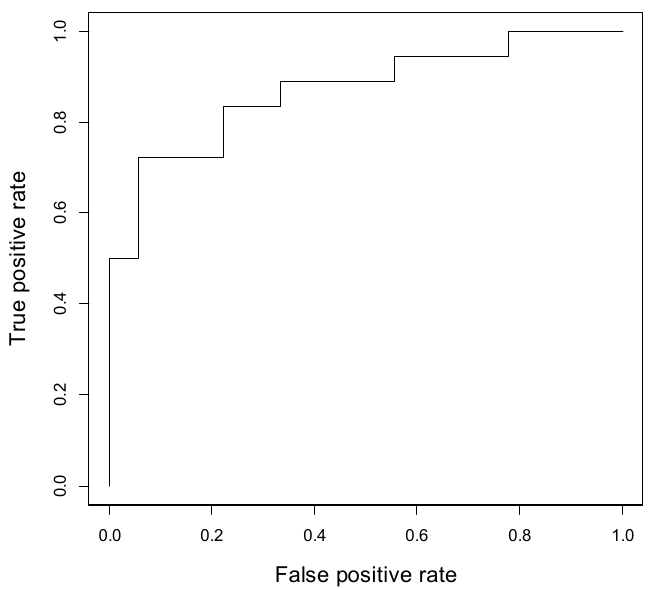
Figure 3. ROC curve of the L21 + L23 lipid peak for differentiating tumor from normal FGT, with an